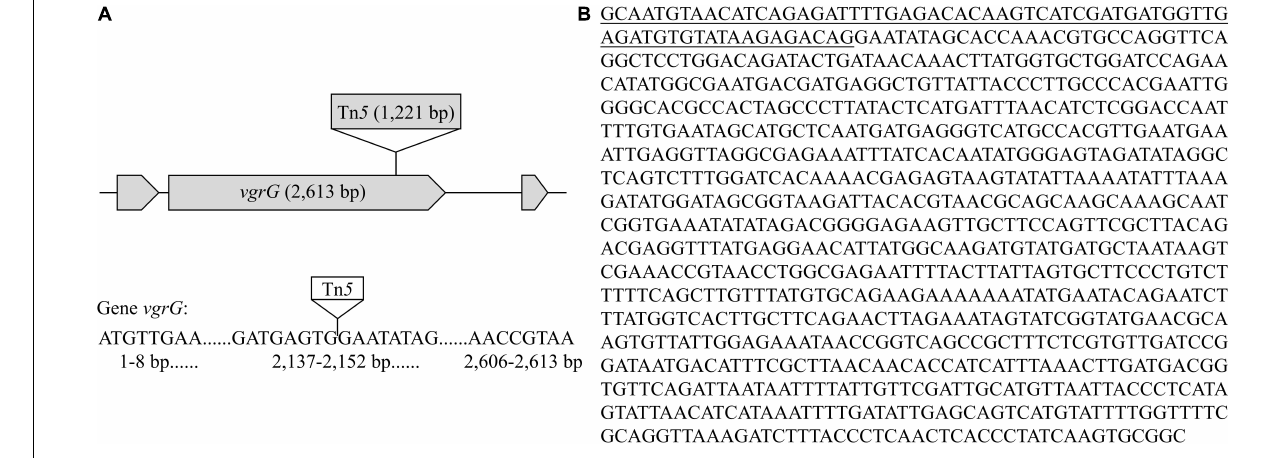
FIGURE 6 | Characterization and sequence analysis of mutant Pa82-87-1. (A) Schematic diagram of Tn 5 transposon insertion in the vgrG gene; (B) Flanking sequence adjacent to Tn 5 transposon insertion site in mutant Pa82-87-1. The underlined part is the residual sequence of Tn 5 transposon.